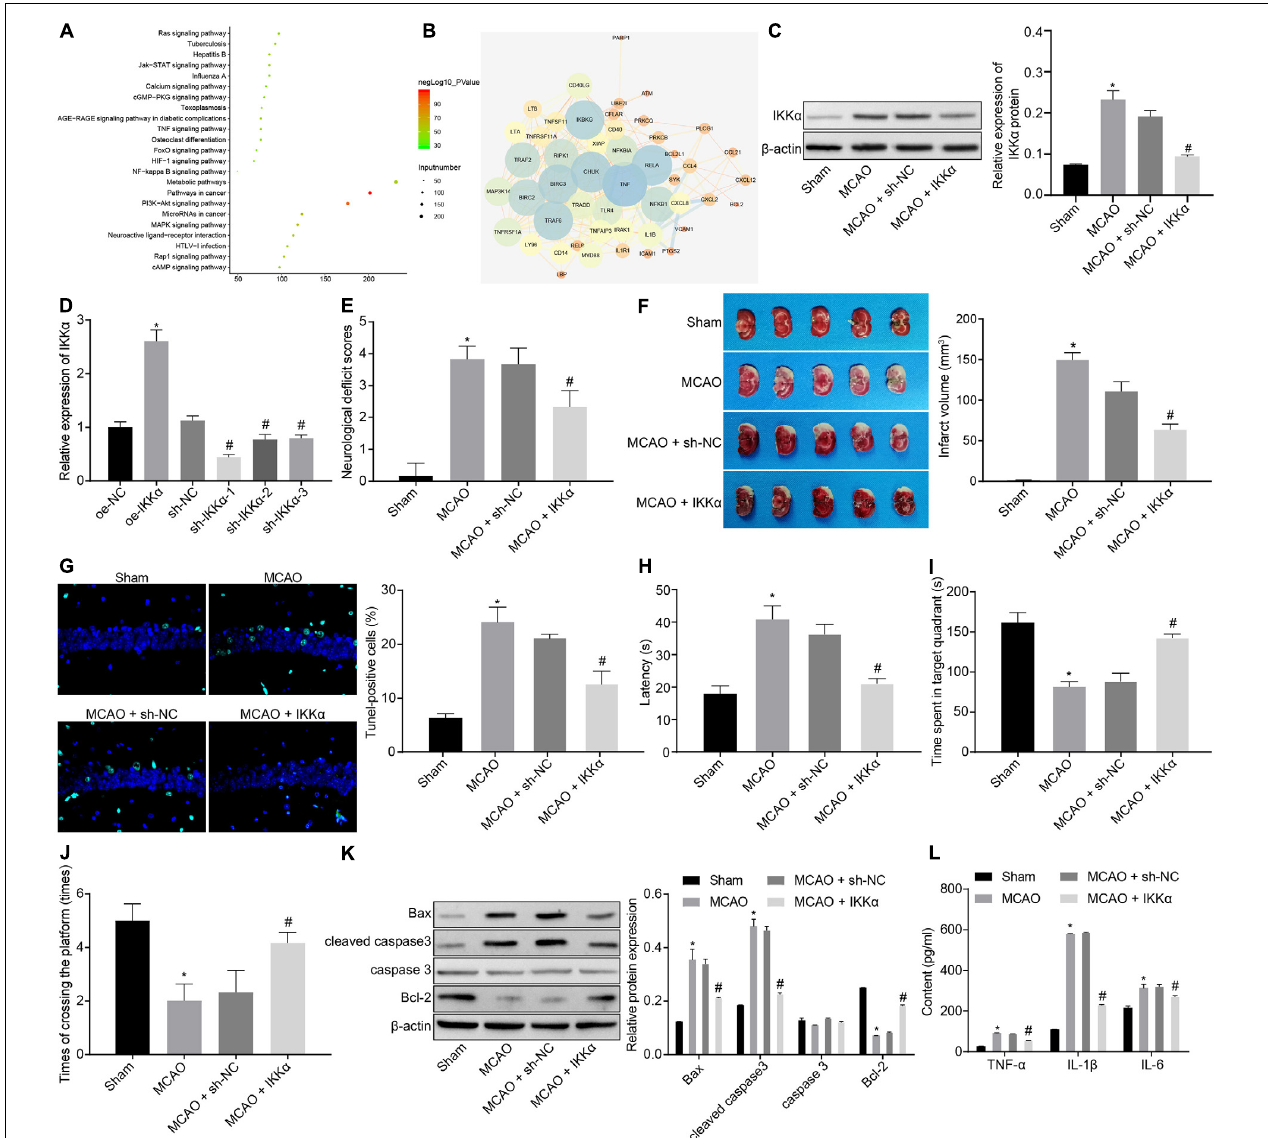
FIGURE 1 | Inhibition of IKK α contributes to prevention of IBI. (A) KEGG enrichment analysis on genes on the KOBAS 3.0 website, with the abscissa representing p value, the ordinate representing the name of the pathway, and the dot size referring to the number of genes involved in the pathway. (B) The network diagram of interaction relations among 50 genes analyzed by the STRING website, with the circle from large to small representing the degree value of the gene, the circle color from blue to orange suggesting the degree from large to small, and the line in the middle referring to the co-expression relationship between genes. (C) Western blot analysis for determination of the protein expression of IKK α . (D) The overexpressing or silencing effect of lentivirus in neuronal cells determined by RT-qPCR. (E) mNSS of rats. (F) Results of TTC staining for typical cerebral infarction foci in rats. (G) Detection of neuronal cell apoptosis in rats by TUNEL (400 × ). (H) The latency time of rats evaluated by MWM. (I) Ratio of time spent by rats staying in the quadrant of the platform. (J) The number of times rats passed through the target platform quadrant. (K) Expression of apoptosis-related proteins (cleaved caspase 3, Bax, Bcl-2, and caspase 3) normalized to β -actin in rat brain tissues determined by western blot analysis. (L) Expression of inflammatory cytokines (TNF- α , IL-1 β , and IL-6) in serum of rats measured by ELISA. In panel (D) , * p < 0.05 vs. neuronal cells treated with oe-NC; # p < 0.05 vs. neuronal cells treated with sh-NC. In panels (E–L) , * p < 0.05 vs. sham-operated rats; # p < 0.05 vs. MCAO-operated rats treated with sh-NC. Measurement data were expressed as mean ± standard deviation. Unpaired data in compliance with normal distribution and homogeneity between two groups were compared using an unpaired t -test. Comparisons among multiple groups were conducted by one-way ANOVA with Tukey’s post hoc test. The cell experiment was repeated three times